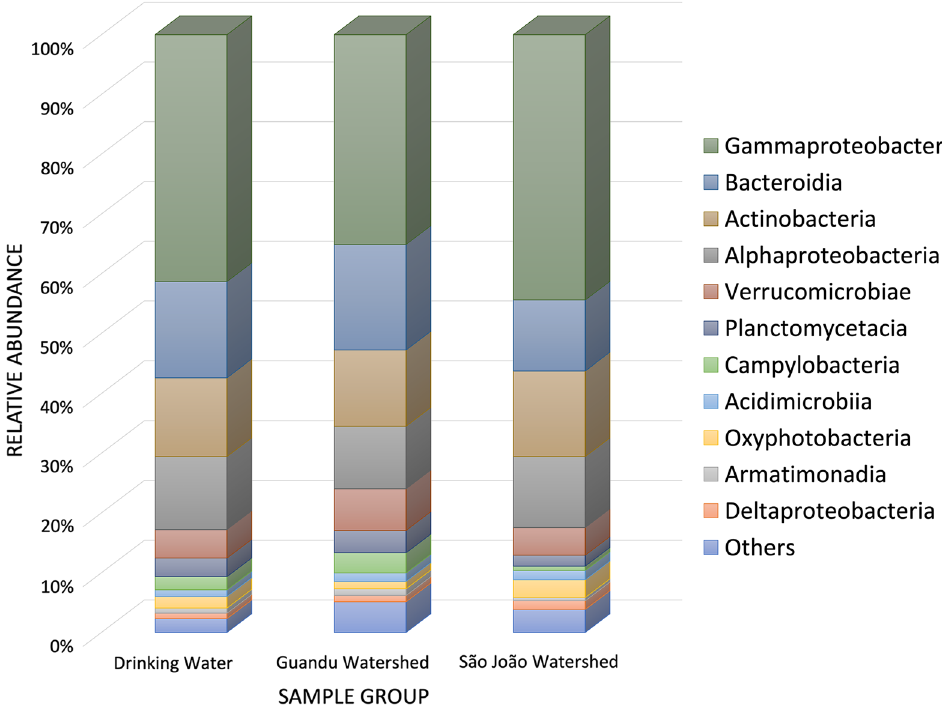
Figure 2. Relative abundance of bacterial composition at the class level in grouped samples of São João watershed, Guandu watershed, and Drinking